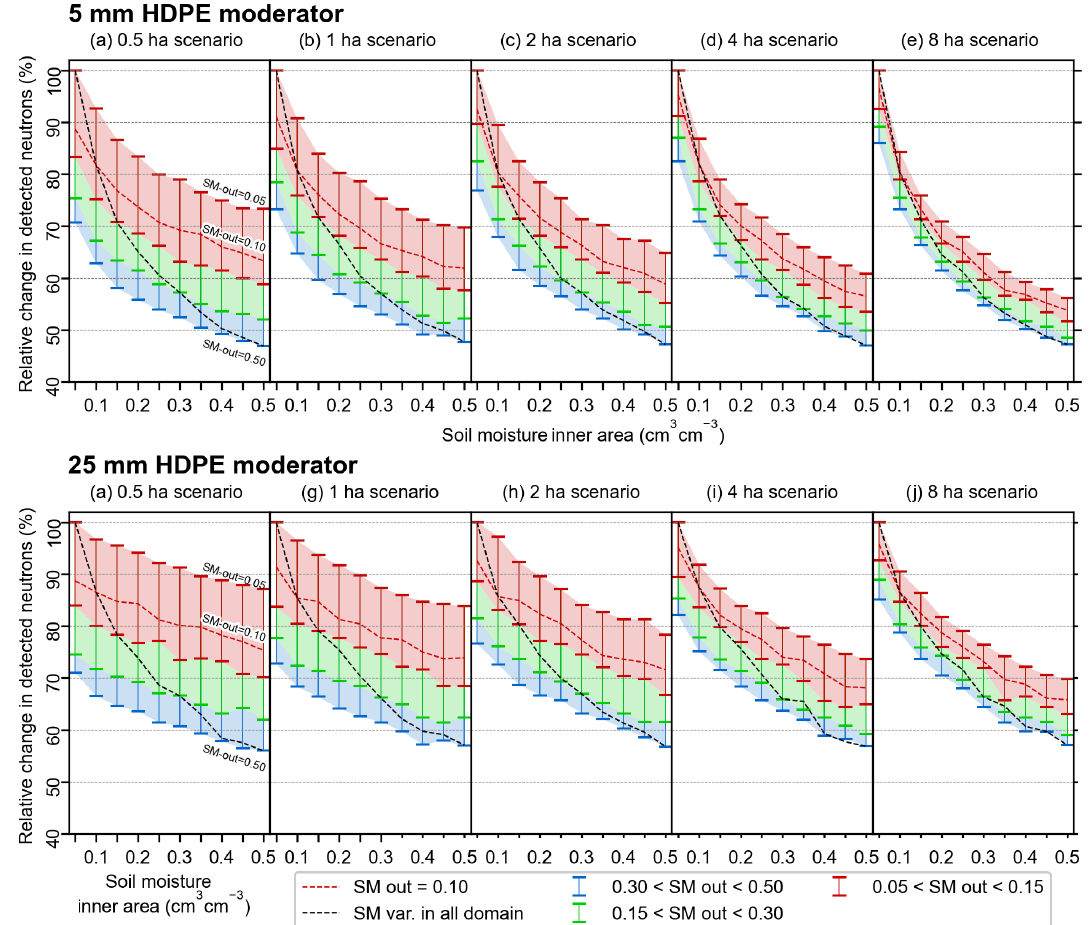
Figure C1. Relative changes in detected neutrons due to SM variations in (a) 0.5, (b) 1, (c) 2, (d) 4, and (e) 8ha irrigated areas for a 5mm HDPE moderator and in (f) 0.5, (g) 1, (h) 2, (i) 4, and (l) 8ha for a 25mm HDPE moderator. The dashed black line shows SM variations that are homogeneous within the simulated domain. The dashed red lines and the error bars indicate SM variations that occur only within the irrigated area for a different SM in the outer